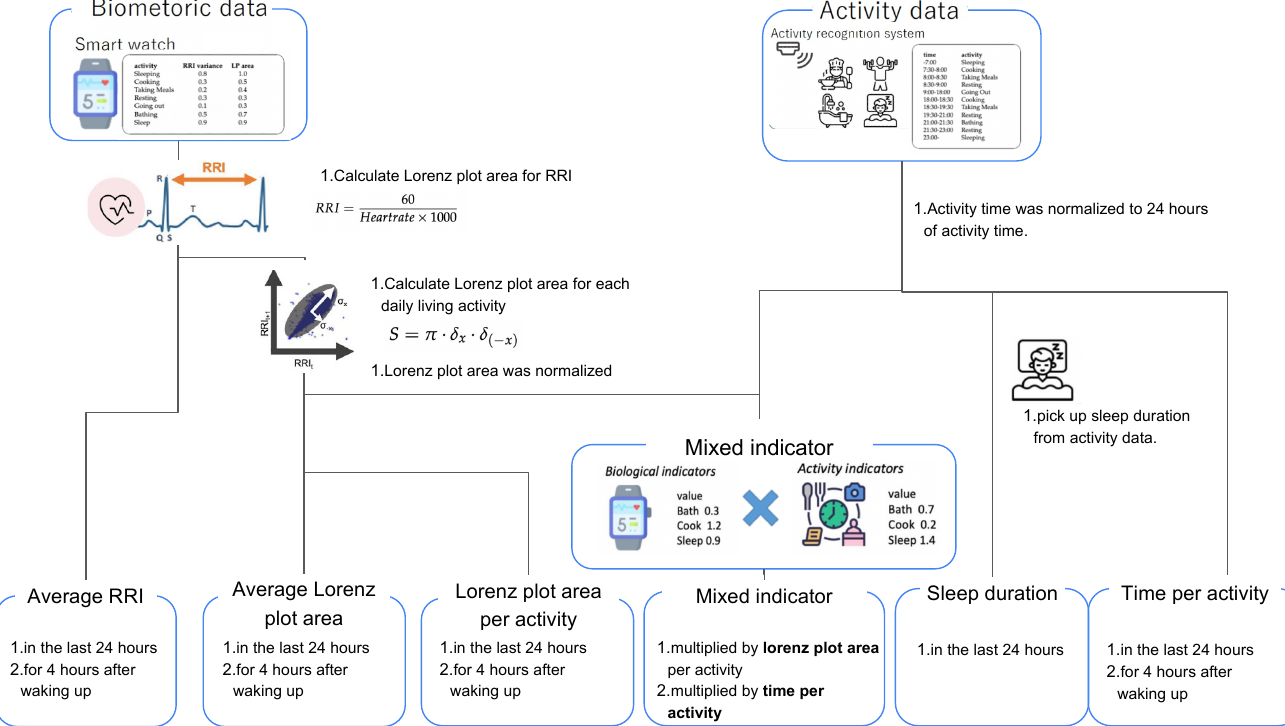
Figure 4. Overview of stress recognition